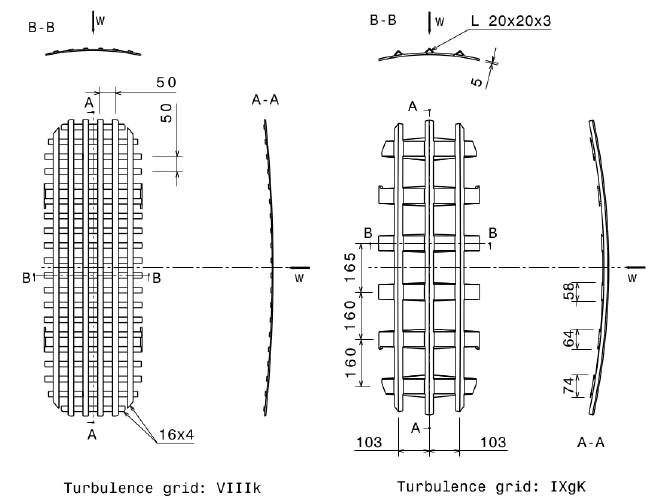
Figure 7. Geometry details of two commonly used turbulence grids VIIIk ( left ) and IXgK ( right